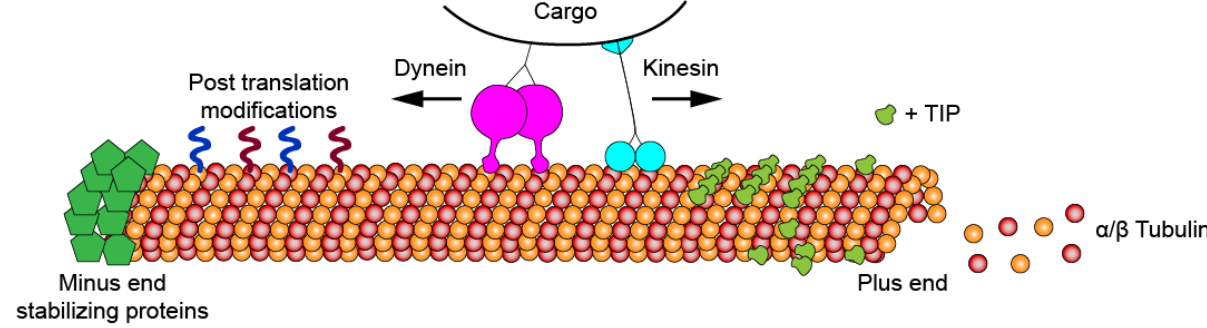
Figure 1. The cartoon illustrates different MAPs that interact with the